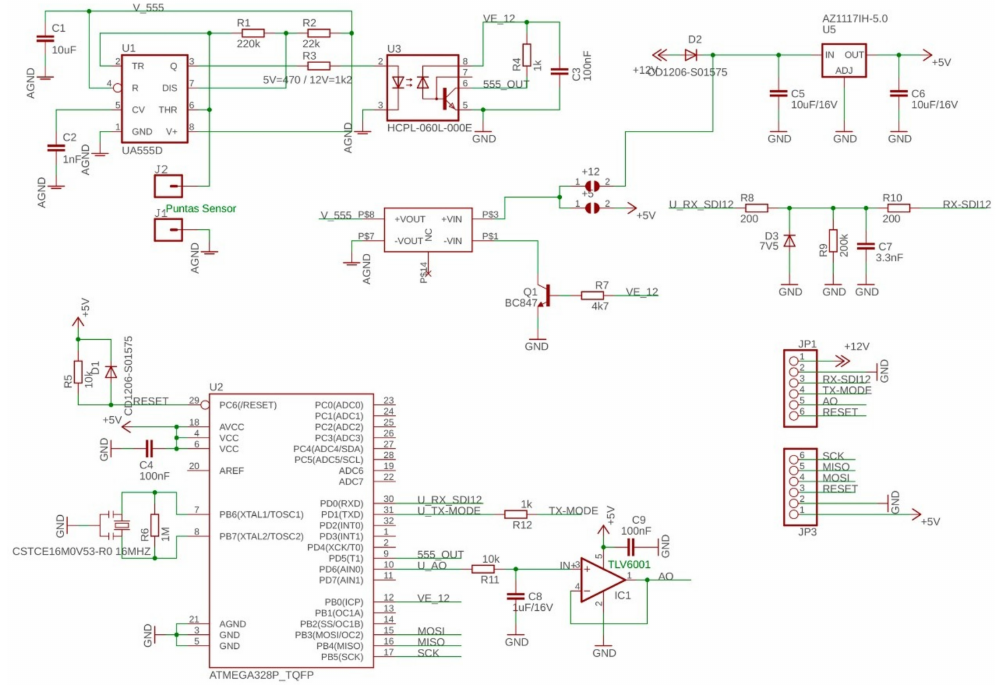
Scheme A1. Experimental sensor